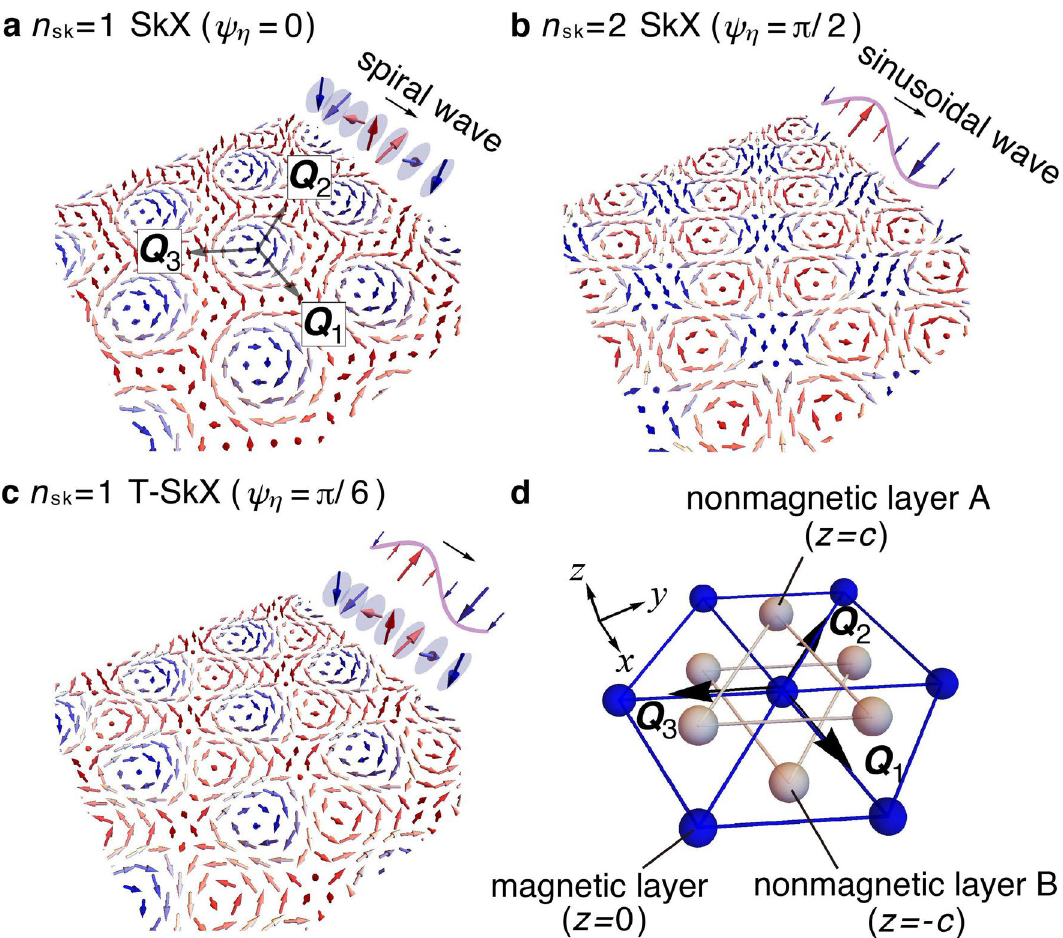
Figure 1. Schematic pictures of the SkXs and the crystal structure. ( a – c ) SkXs characterized by three spiral and 0 , ( b ) the n sk 1 SkX for ψ 2 SkX for sinusoidal waves along the Q 1 , Q 2 , and Q 3 directions: ( a ) the n sk η = = = 6 in Eq. (1). ( d ) Centrosymmetric trigonal structure without 1 T-SkX for ψ ψ η π/ 2 , and ( c ) the n sk η = π/ = = c ) c ( the horizontal mirror plane. The blue spheres represent magnetic sites, while the gray spheres shifted by − + from the center of the downward (upward) triangles on the magnetic layer represent nonmagnetic sites on a layer A